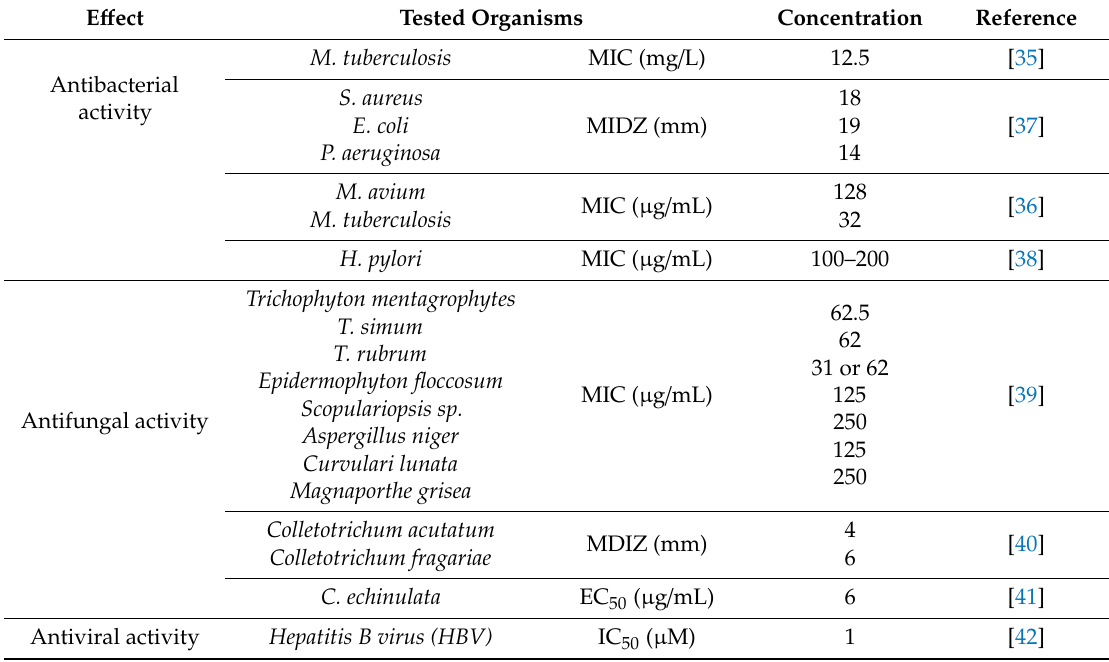
Table 1. Antimicrobial activity of